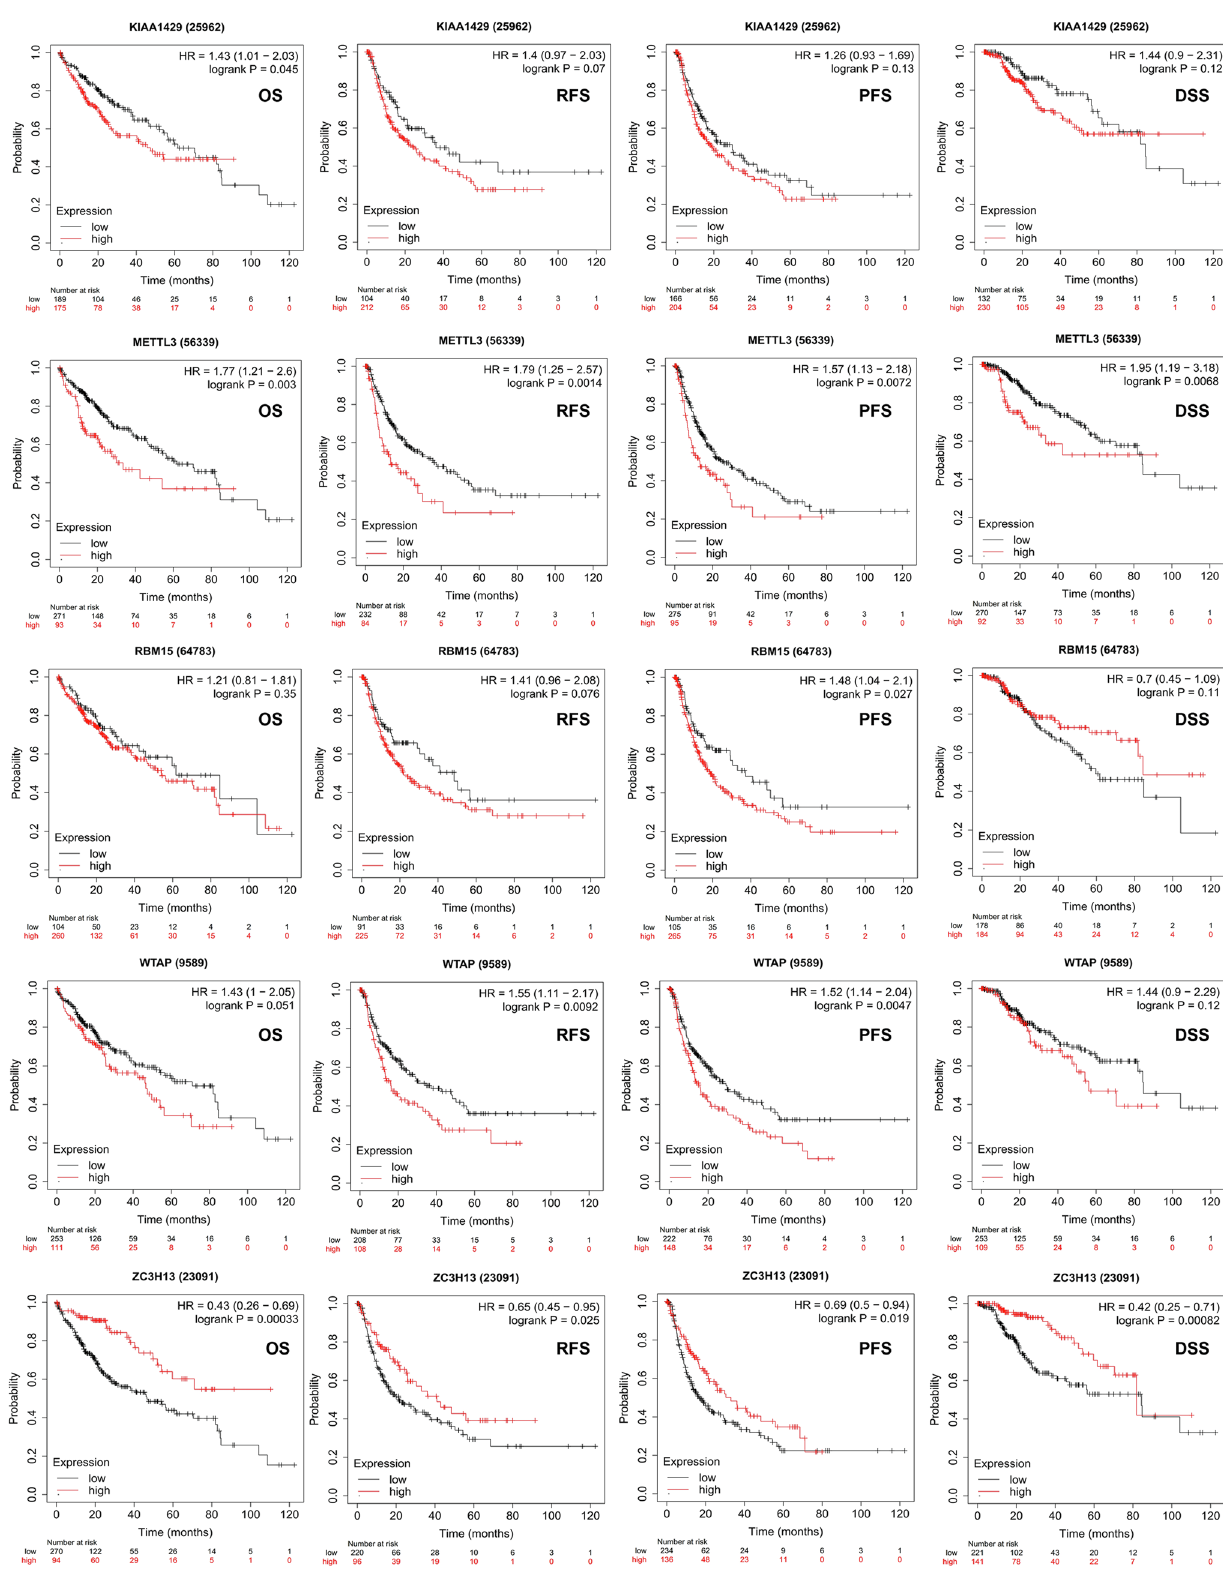
Fig. 4 Prognostic feature of mRNA expression of distinct m6A regulators and PD-L1 in HCC patients (Kaplan–Meier plotter). The OS, RFS, PFS and DSS survival curves comparing patients with high (red) and low (black) m6A regulators and PD-L1 expression in HCC were plotted using the Kaplan–Meier plotter database at the threshold of p-value of <